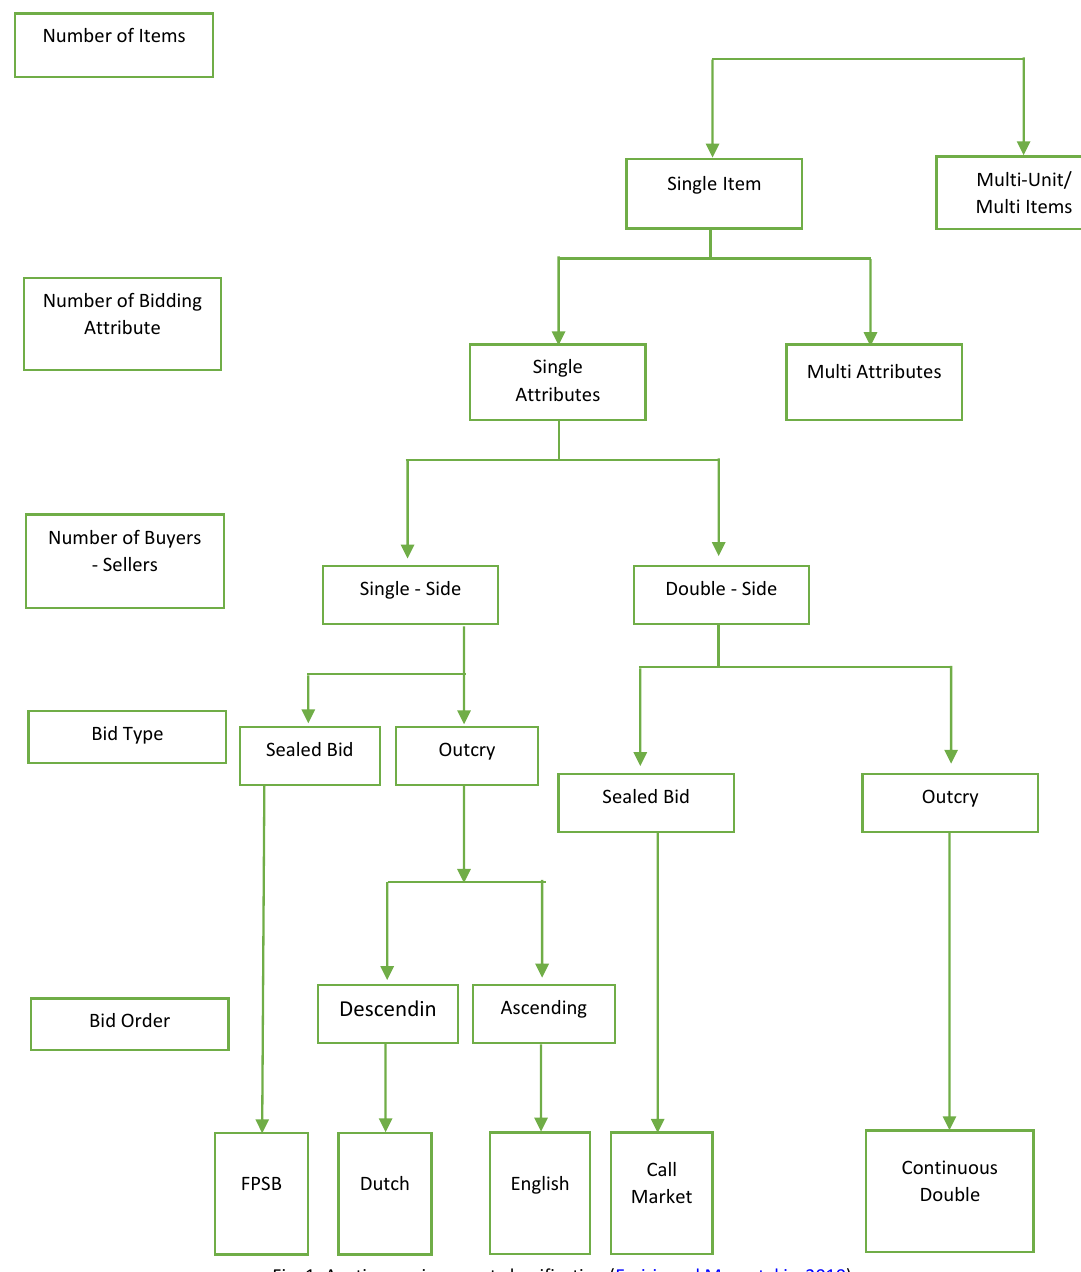
Fig. 1: Auction environment classification (Emiris and Marentakis, 2010 Fig. 1. Auction environment classification (Emiris and Marentakis, 2010)